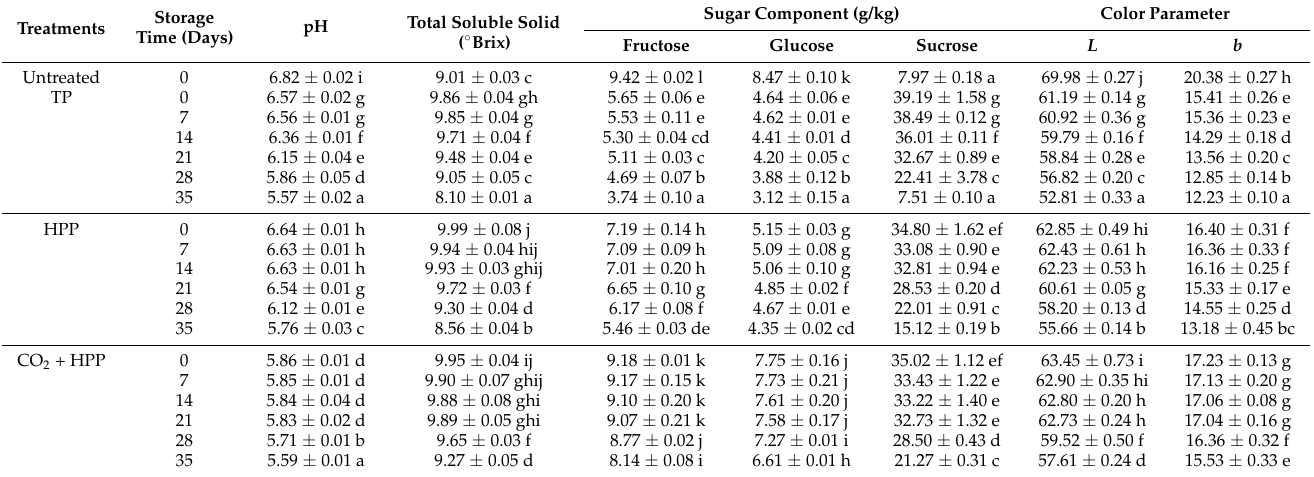
Table 1. Effects of TP (95 ◦ C, 60 min), HPP (600 Mpa) and CO 2 + HPP (600 Mpa) treatments on pH, total soluble solids, sugars, and color parameters of DFPs during